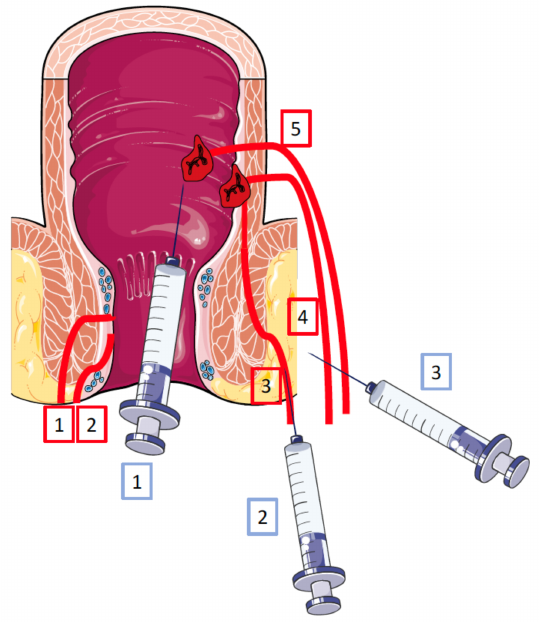
Figure 4. Schematic representation of anoperineal fistulas in Crohn’s disease and of adipose-derived stem cell injections. The different types of fistulas are drawn in red. According to Park’s classification: 1: superficial; 2: inter-sphincteric; 3: trans-sphincter; 4: supra-sphincteric; 5: extra-sphincteric. According to the American Gastroenterological Association: simple fistulas = 1 + 2; complex fistulas = 3 + 4 + 5. In blue, different ADSC routes that are generally applied in refractory complex fistulas: 1: via the internal orifice of the fistula; 2: via the external orifice of the fistula; 3: in the peri-fistula